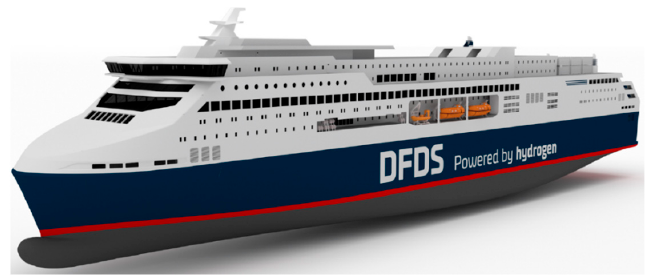
Figure 38. The ferry “EuropaSeaways” [171].